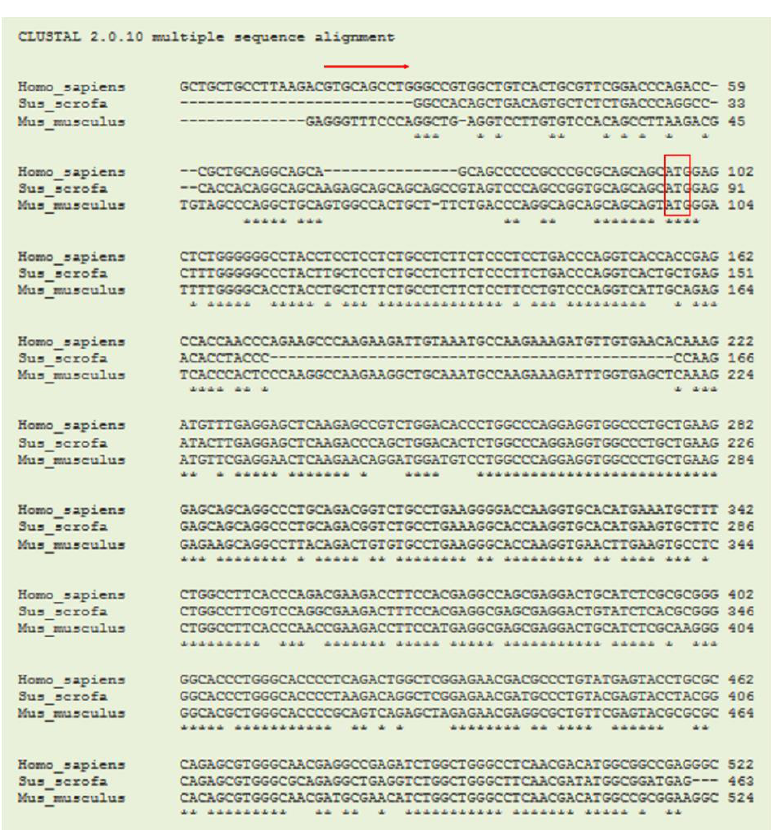
Figure 1. Sequence alignments of TN genes in species. A coding region sequence of the 378-bp porcine ( Sus scrofa ) tetranectin (TN/ CLEC3B ) from cDNA was cloned and aligned to those of humans ( Homo sapiens ) and mice ( Mus musculus ) using the ClustalW program. The arrow indicates the starting exon 1. The box indicates the translation start site. Asterisks indicate bases of homology between all three